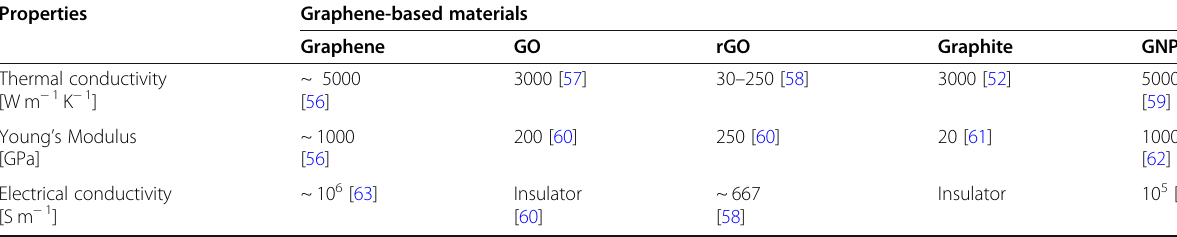
Table 2 Mechanical and physical properties of graphene-based materials